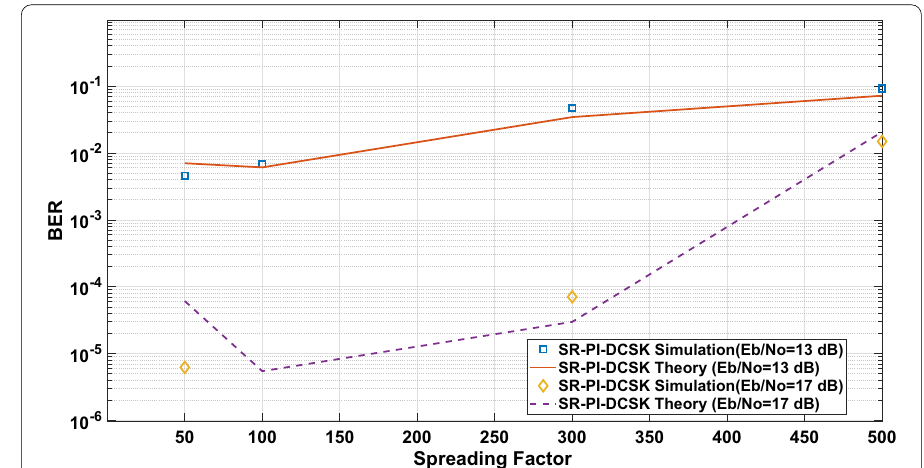
Fig. 16 Theoretical and simulation bit error performance for SR‑PI‑DCSK at different spreading values and L =